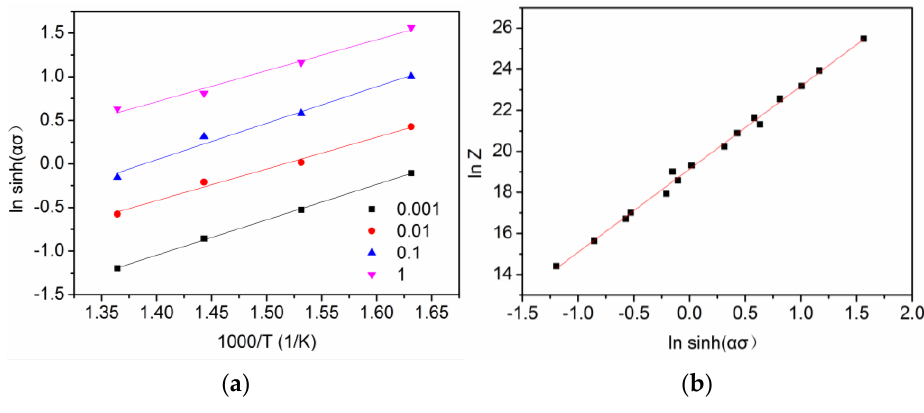
Figure 9. ln[sinh(ασ)]-1000 / T ( a ); ln -ln[sinh(ασ)] Z ( b ). Figure 9. ln [ sinh ( ασ )]